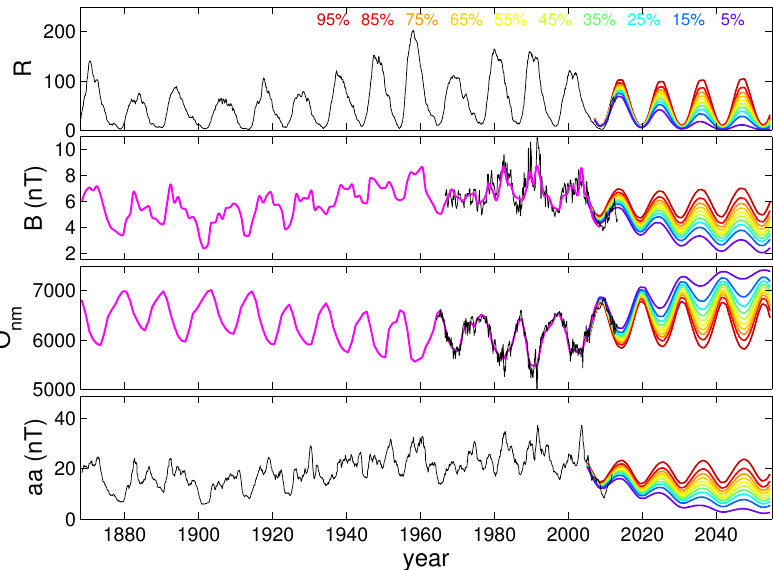
Figure 38: Observed past and predicted future variations of (from top to bottom): sunspot number, 𝑅 ; interplanetary magnetic field strength at Earth, 𝐵 ; cosmic ray counts by the Oulu neutron monitor, 𝑂 nm ; and the 𝑎𝑎 geomagnetic index. The black lines are monthly averages of observations. The mauve line in the second panel is the LEA09 reconstruction of annual means of 𝐵 from geomagnetic data by Lockwood et al. (2009d), and that in the third panel from the reconstruction of 𝜑 by Usoskin et al. (2002). The red-to-blue lines show predicted variations of annual means at various probabilities, made from the 9300- year cosmogenic isotope composite of Steinhilber et al. (2008) using the procedure developed by Lockwood et al. (2011a) and Barnard et al. (2011). In the top panel the blue to red lines show the values of 𝑅 which have a probability 𝑃 [ < 𝑅 ] = [0 . 05 : 0 . 1 : 0 . 95] that 𝑅 will be lower than the value shown. Corresponding predictions are given in the other panels. (Note that in the third panel the probability of 𝑃 [ > 𝑂 nm ] is shown as 𝑂 nm rises as solar activity falls). Image adapted from Lockwood et al.